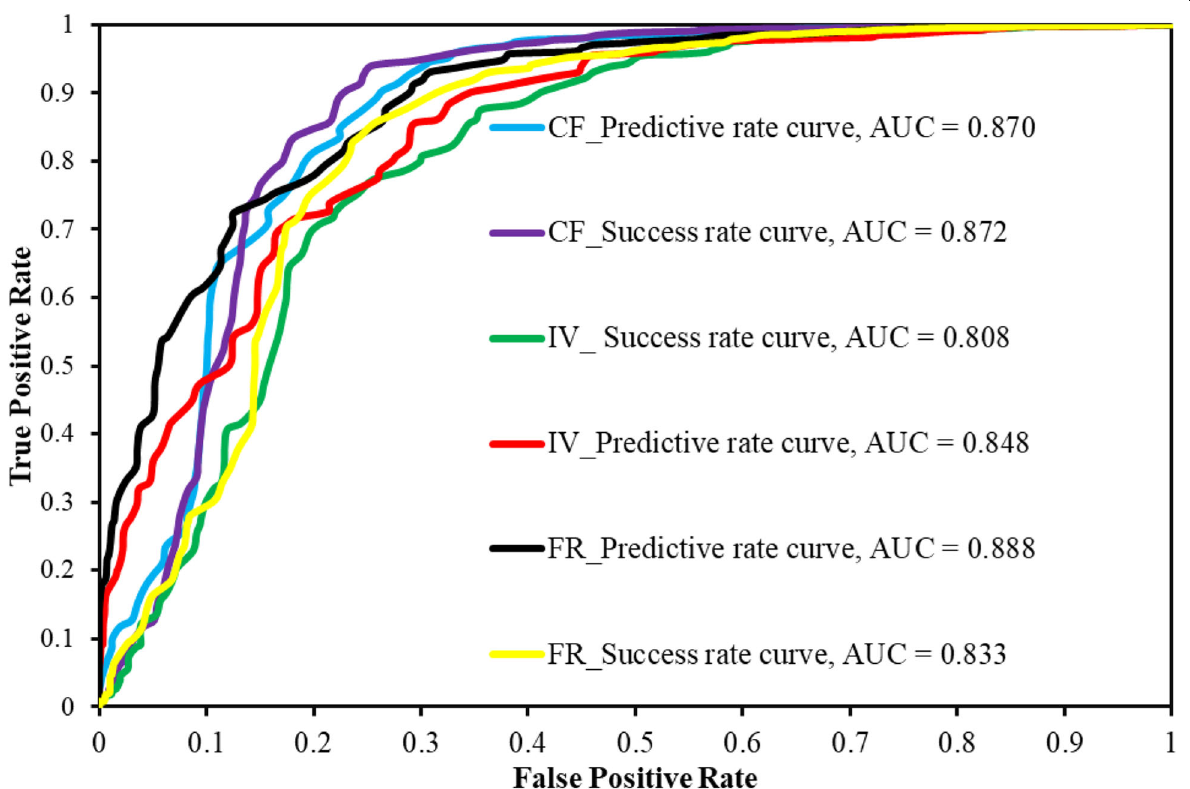
Fig. 11 Receiver Operating Characteristics Curve